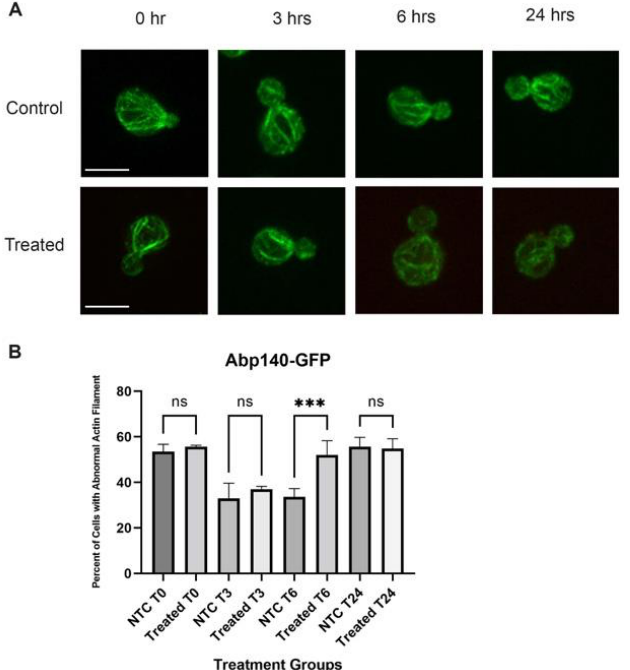
Figure 11. Actin cable integrity assay. ( A ) Abp140-GFP-expressing cells were treated with QDs and visualized over time using the confocal microscope. The size bar is equivalent to 5 μ m. ( B ) Actin cables of 30 cells were assessed for their structure. *** p < 0.001 .